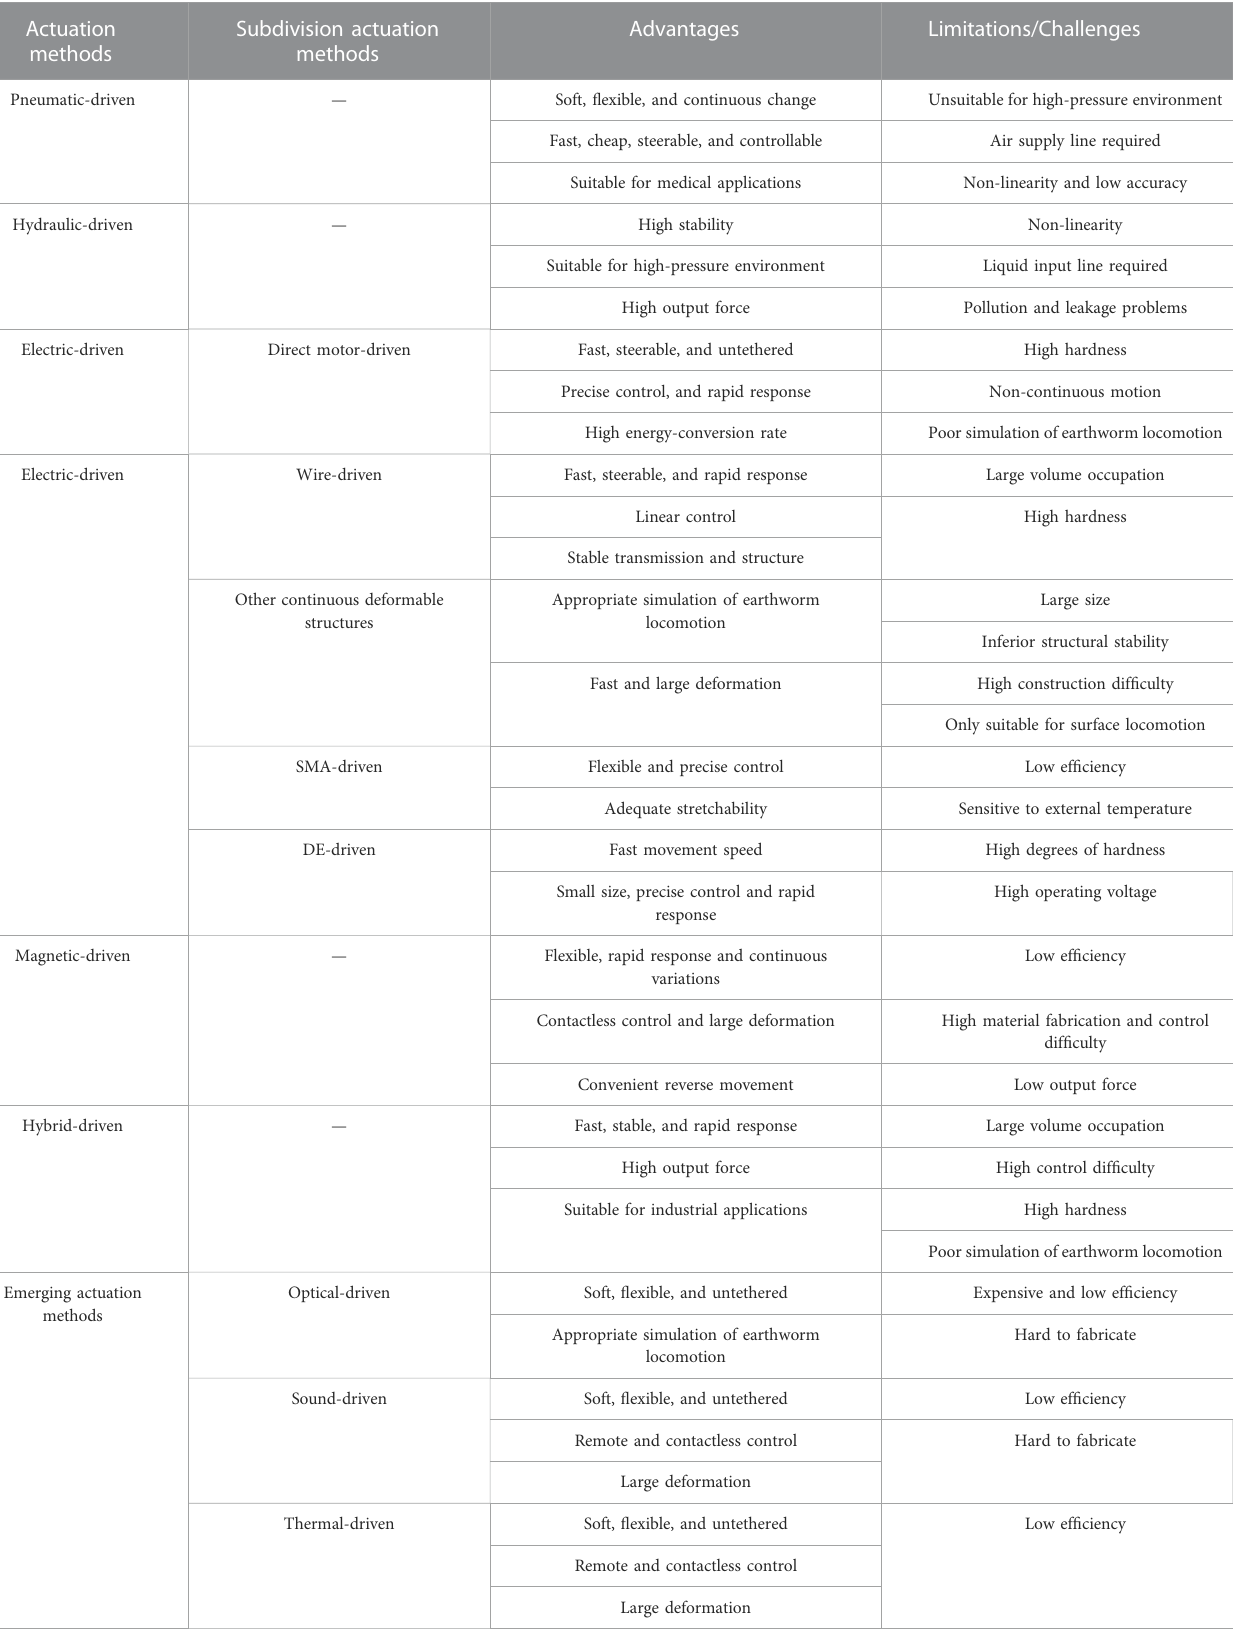
TABLE 1 Comparison between various types of actuation methods in earthworm-inspired soft